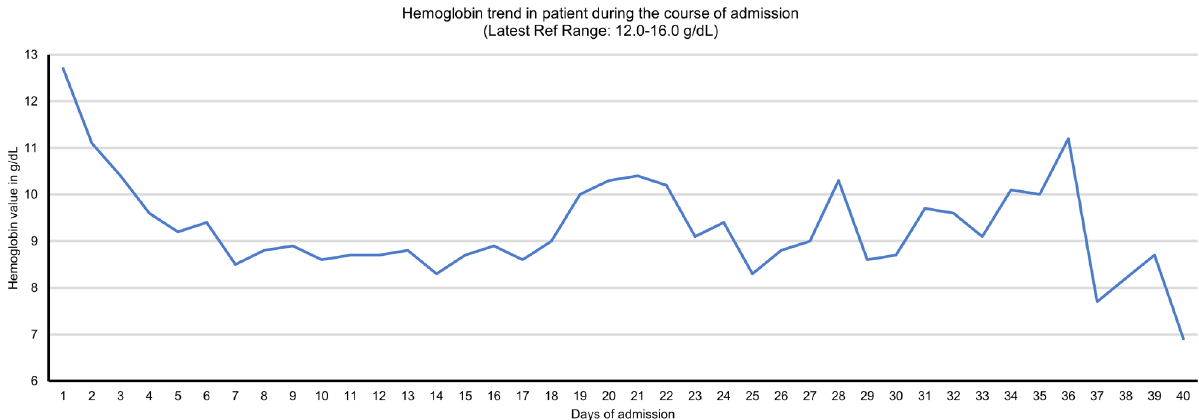
Figure 1. Hemoglobin trend in patient following anticoagulation therapy